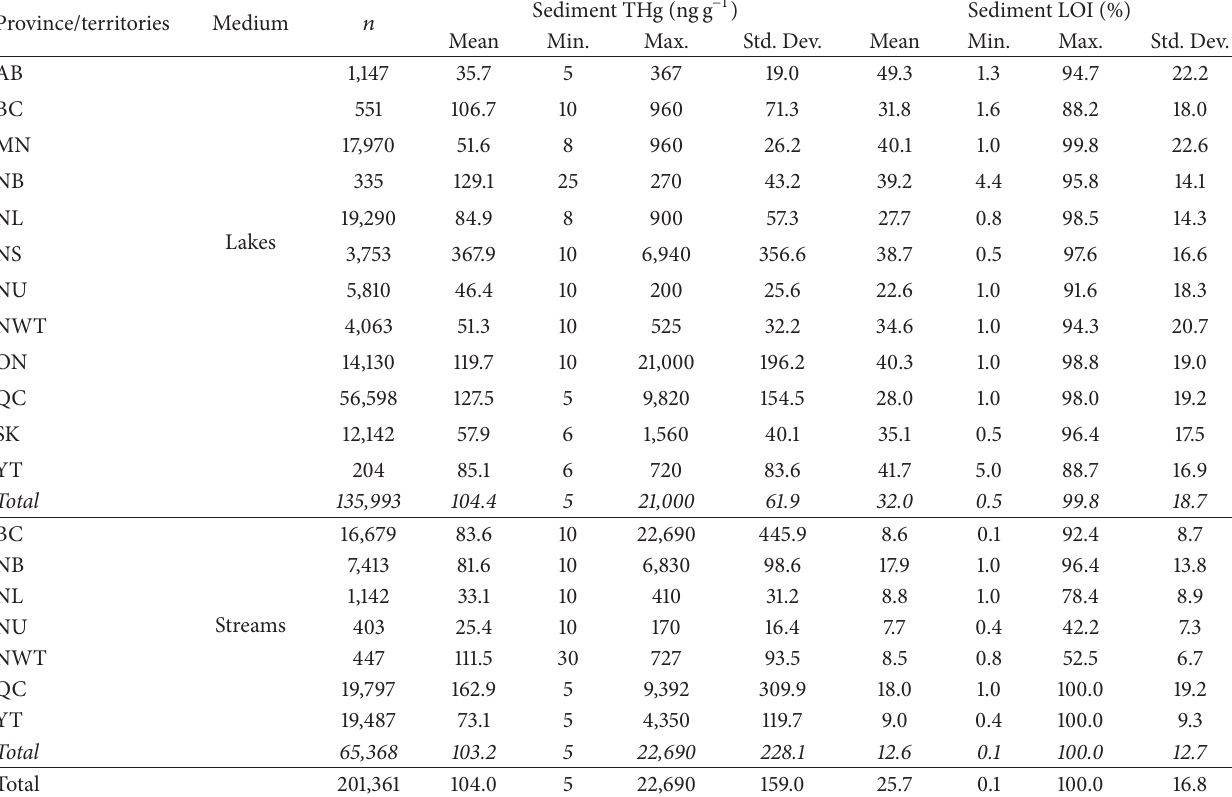
Table 1: Mean sediment THg and LOI for streams and lake, by provinces and territories.